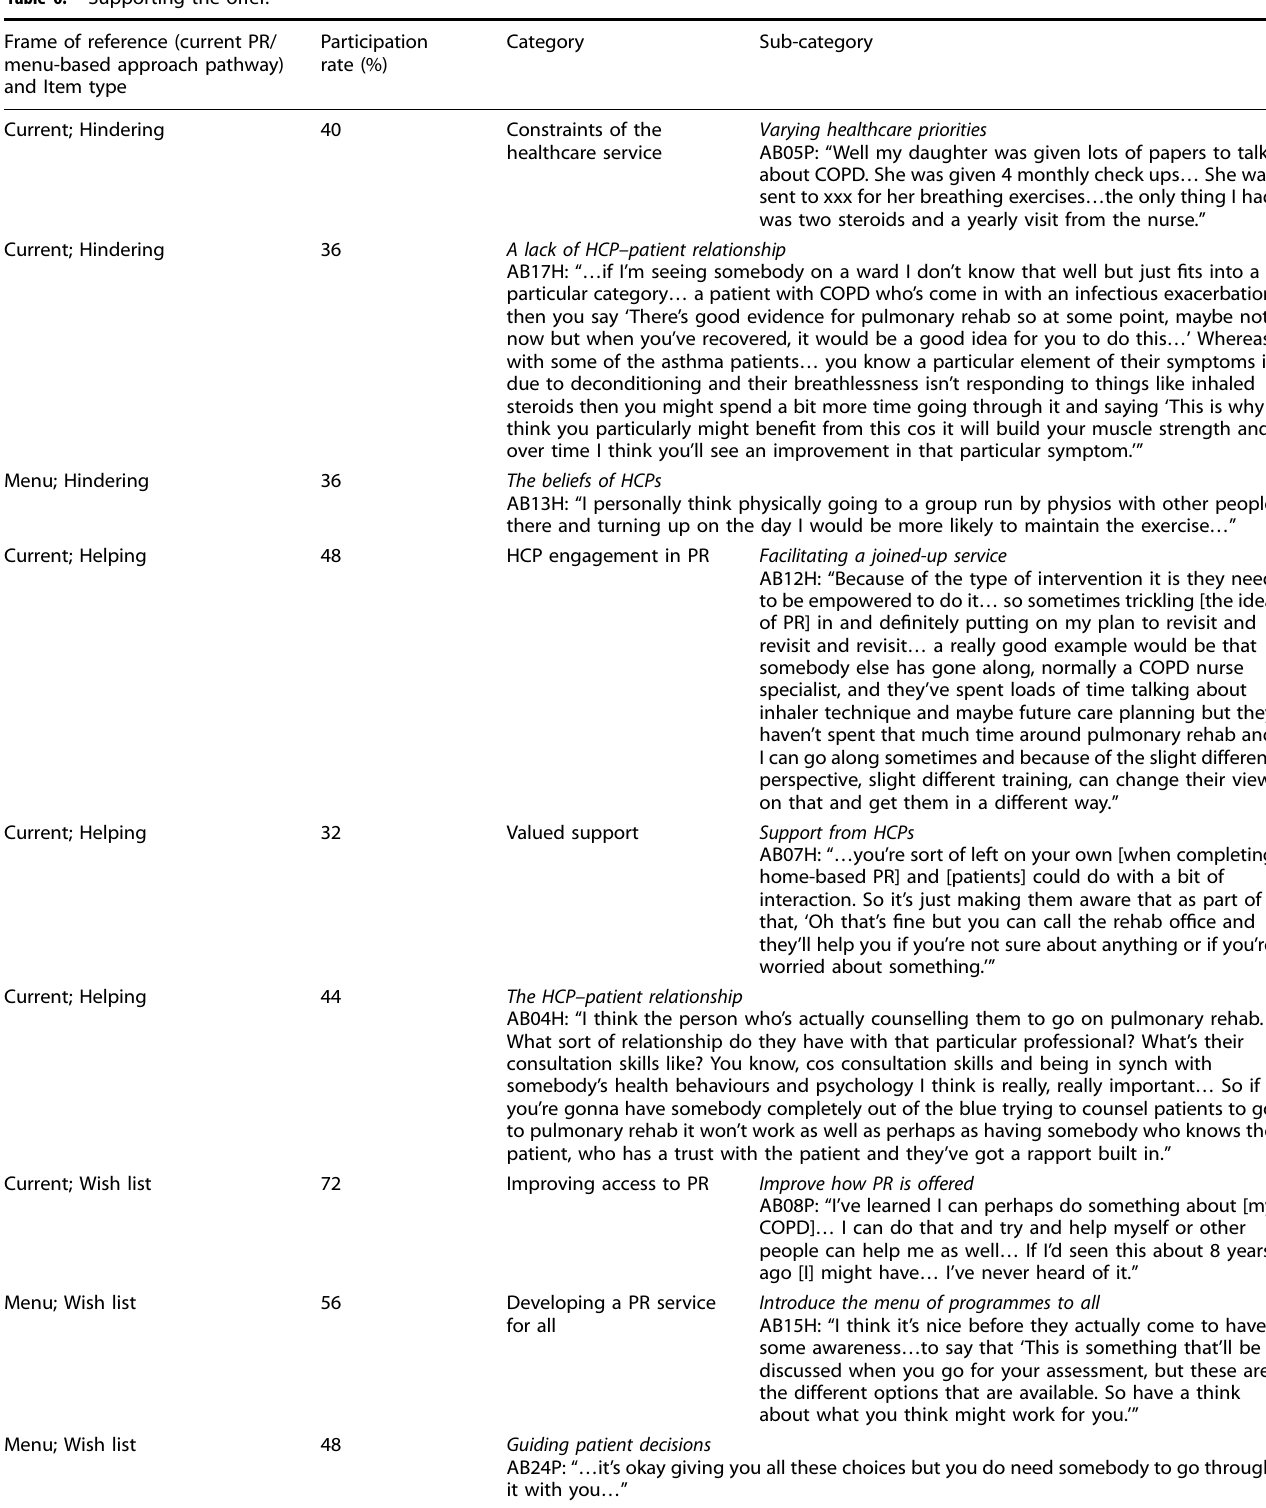
Table 6. Supporting the